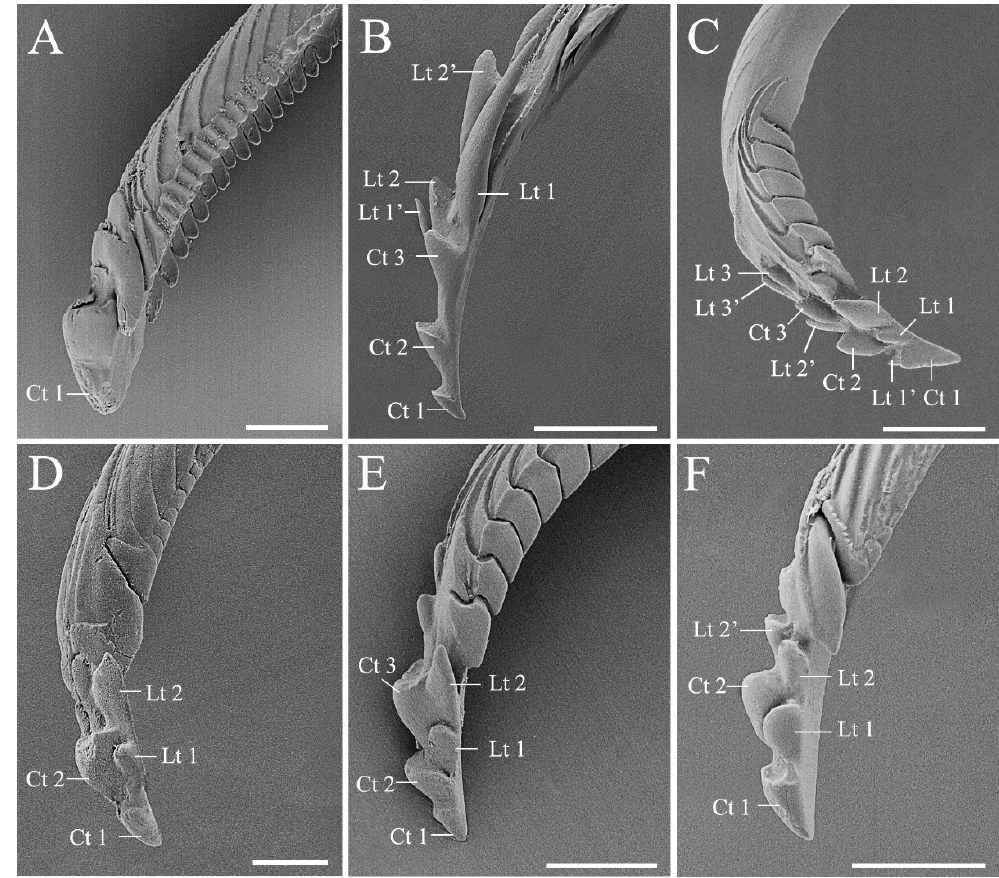
Figure 7. Mandibular stylet of the six pentatomid species. ( A ) Cressona divaricata , ( B ) Eocanthecona furcellata , ( C ) Eurydema dominulus , ( D ) Halyomorpha halys , ( E ) Plautia crossota , and ( F ) Scotinophara lurida . Scale bars: ( A – E ) 25 µ m; ( F ) 15 µ m. Abbreviations: Ct, central teeth; Lt, lateral teeth.